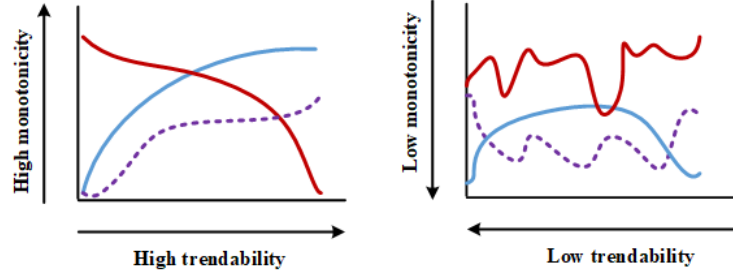
Figure 12. Definition of curve fitness metrics.